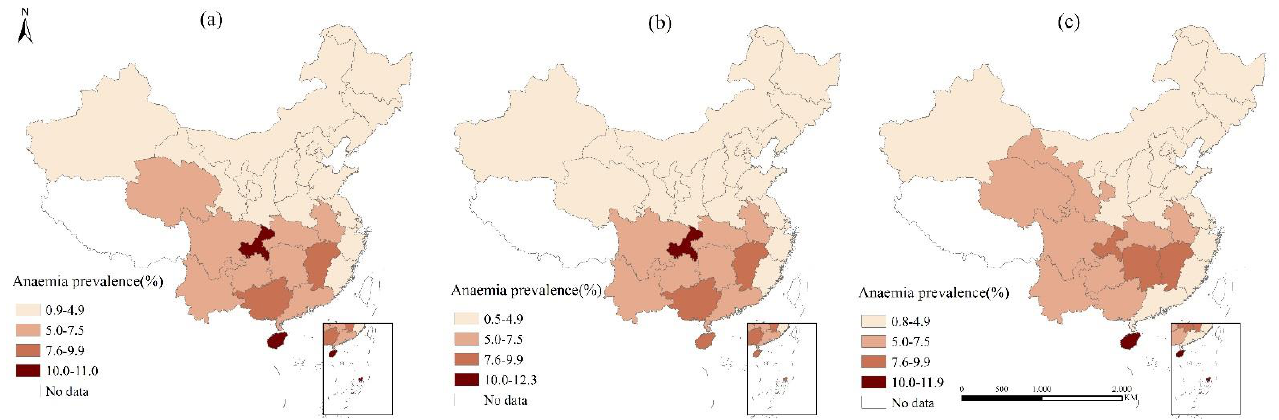
Figure 2. ( a ) Anemia prevalence of children; ( b ) anemia prevalence of boys; ( c ) anemia prevalence of girls.